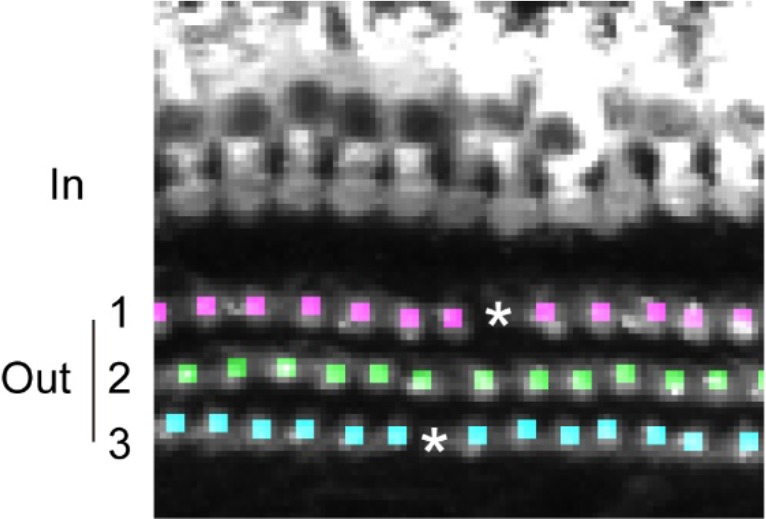
Functions of the third and fourth machine learning models.Cell candidates detected by the first and the second machine learning models were further categorized into three rows by the third model (cells marked by dots with different colors correspond to the three rows.). The spaces between detected OHCs (asterisks) were detected and evaluated the possible presence of OHCs escaped in the previous detection processes.